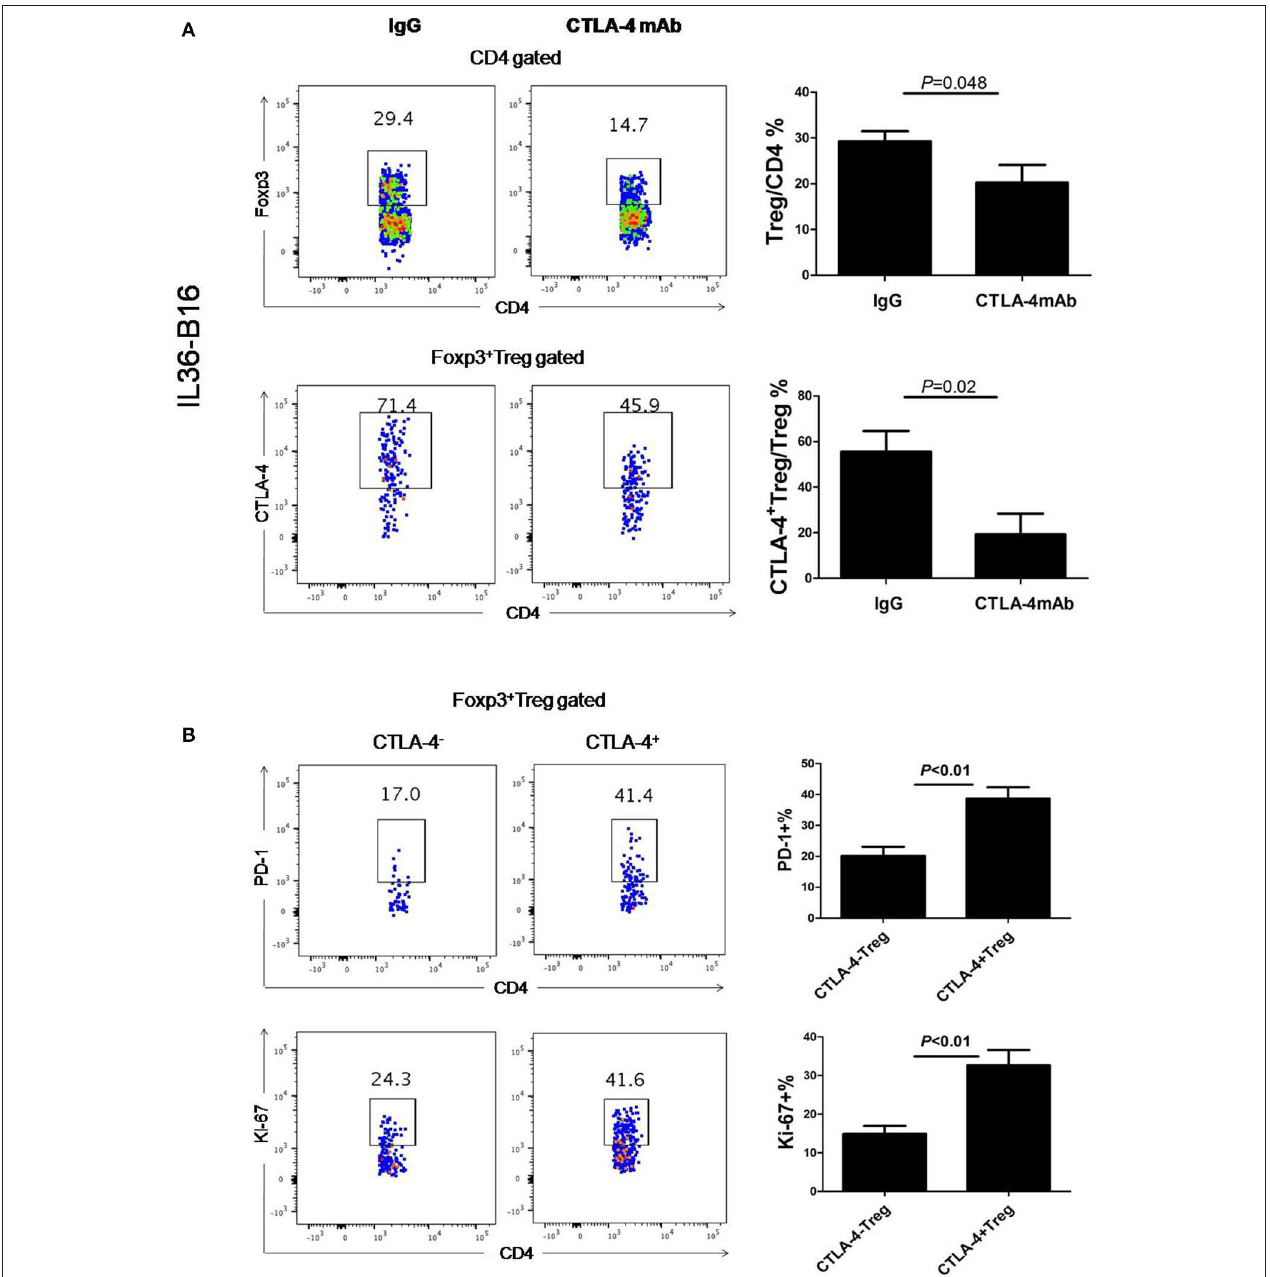
FIGURE 4 | Administration of CTLA-4 mAbs decreased Treg cell population in tumors. (A) , Representative flow cytometry plot showing percentages of Foxp3 + CD4 + TIL and CTLA-4 + Foxp3 + TIL in IL-36-B16 tumors after CTLA-4 mAbs treatment ( n = 3 mice/group). (B) , Representative flow cytometry plot showed PD-1 and Ki-67 expression on CTLA-4 + Foxp3 + and CTLA-4 − Foxp3 + T cell subsets in IL-36-B16 tumors. Data (mean ± SEM) are representative of three independent experiments.